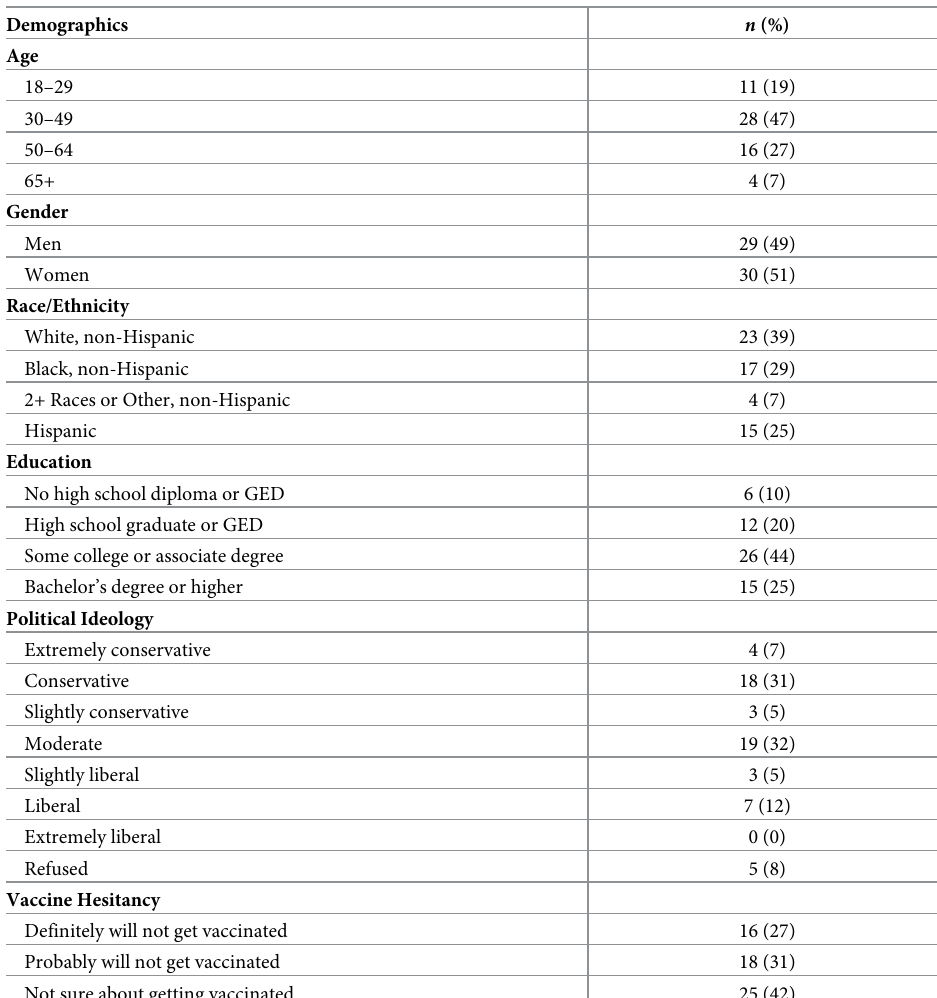
Table 1. Participant characteristics ( n =